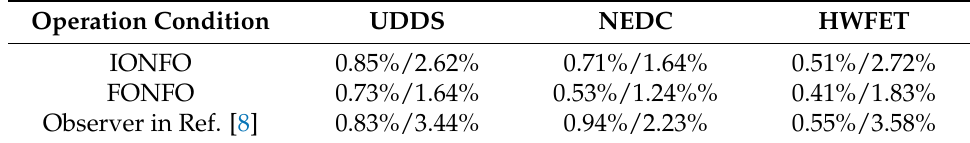
Table 2. Mean/maximum SOC estimation errors of observers after